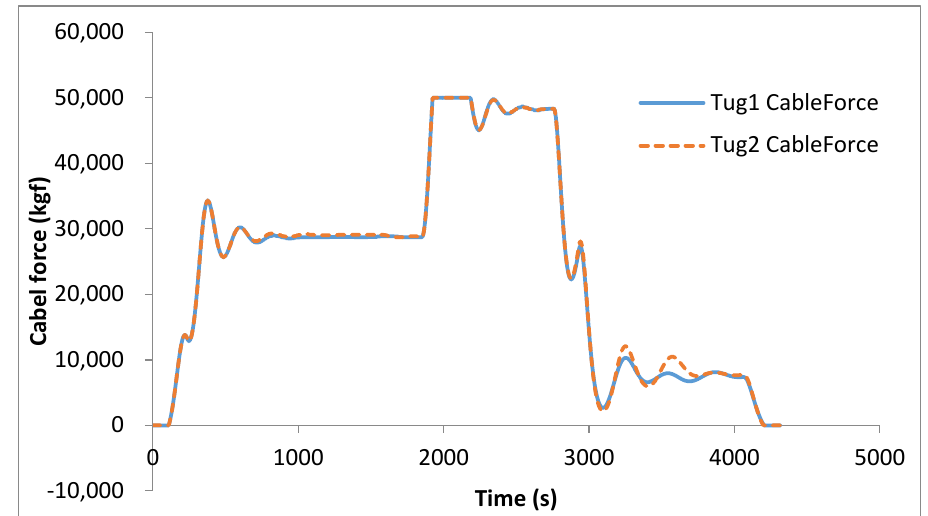
Figure 19. The change of the rope force during the towing process.